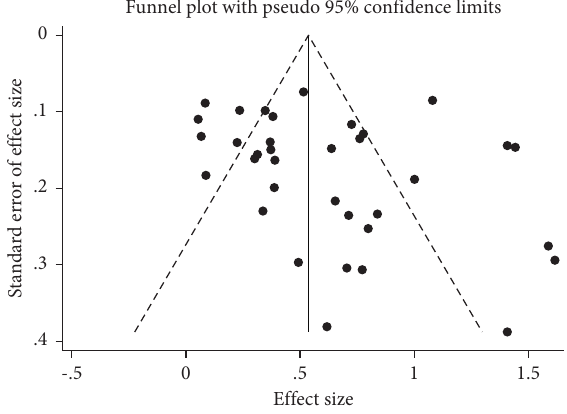
Figure 8: The funnel plot of the data in the